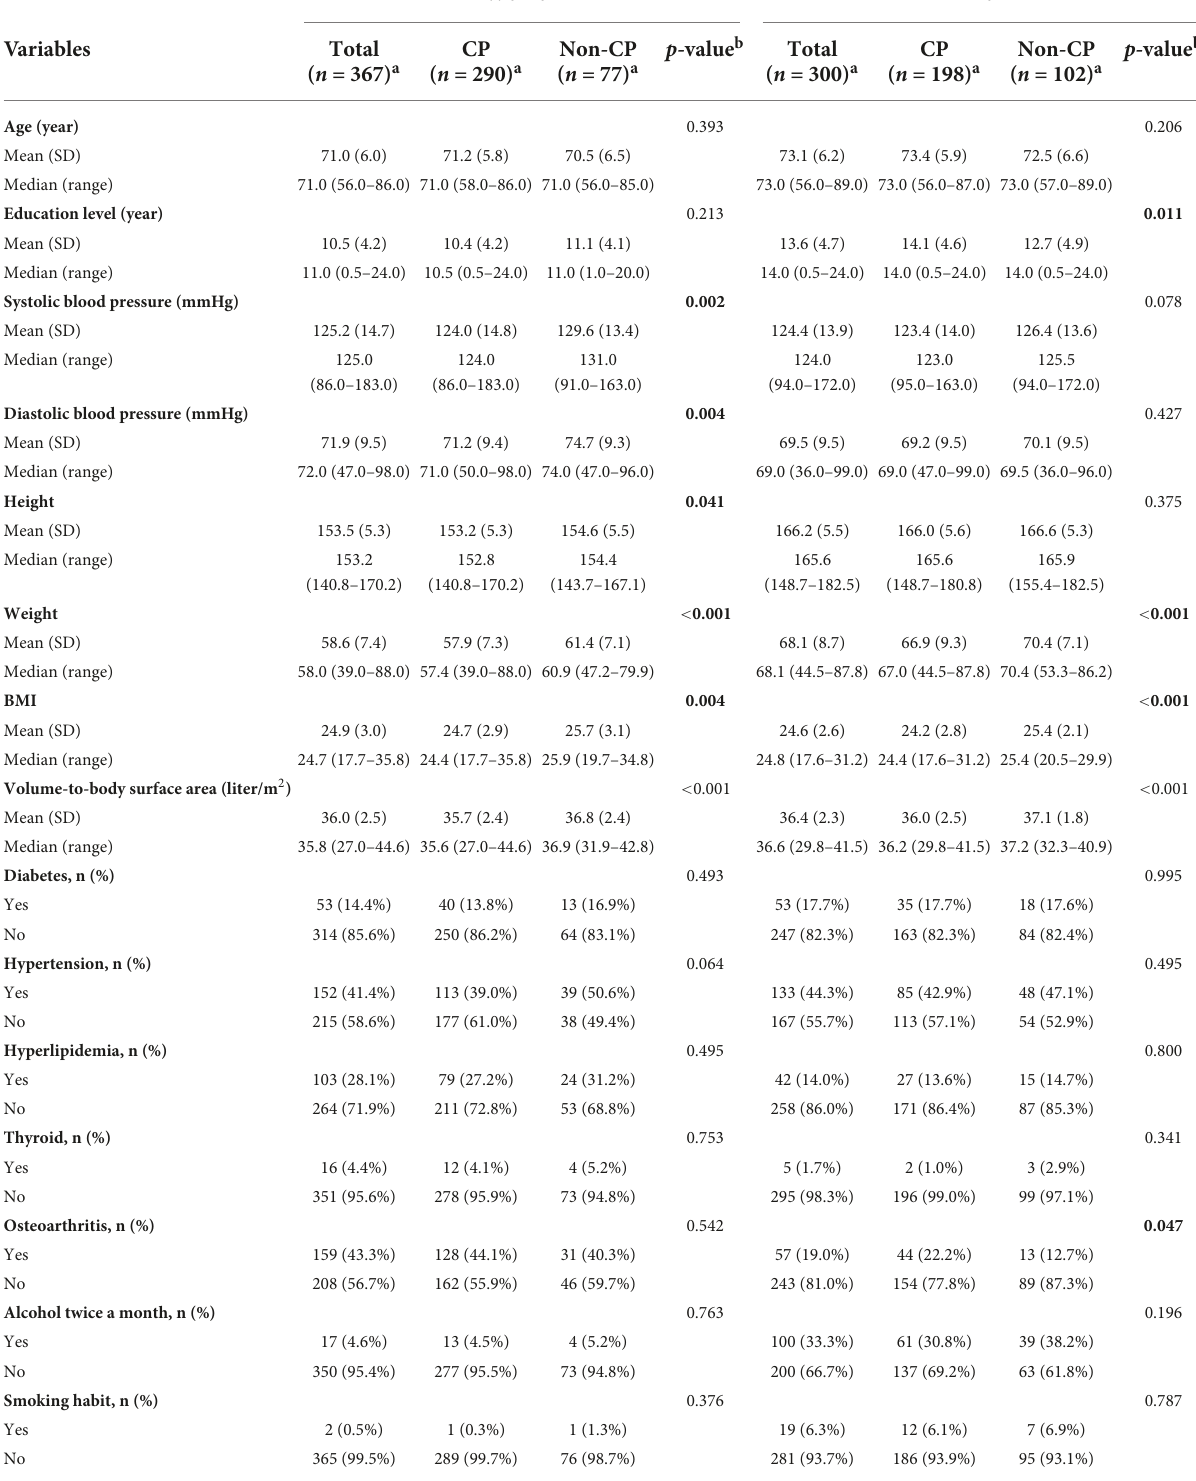
TABLE 2 Demographic information, anthropometric measurements, and the relevant comorbidities in women and